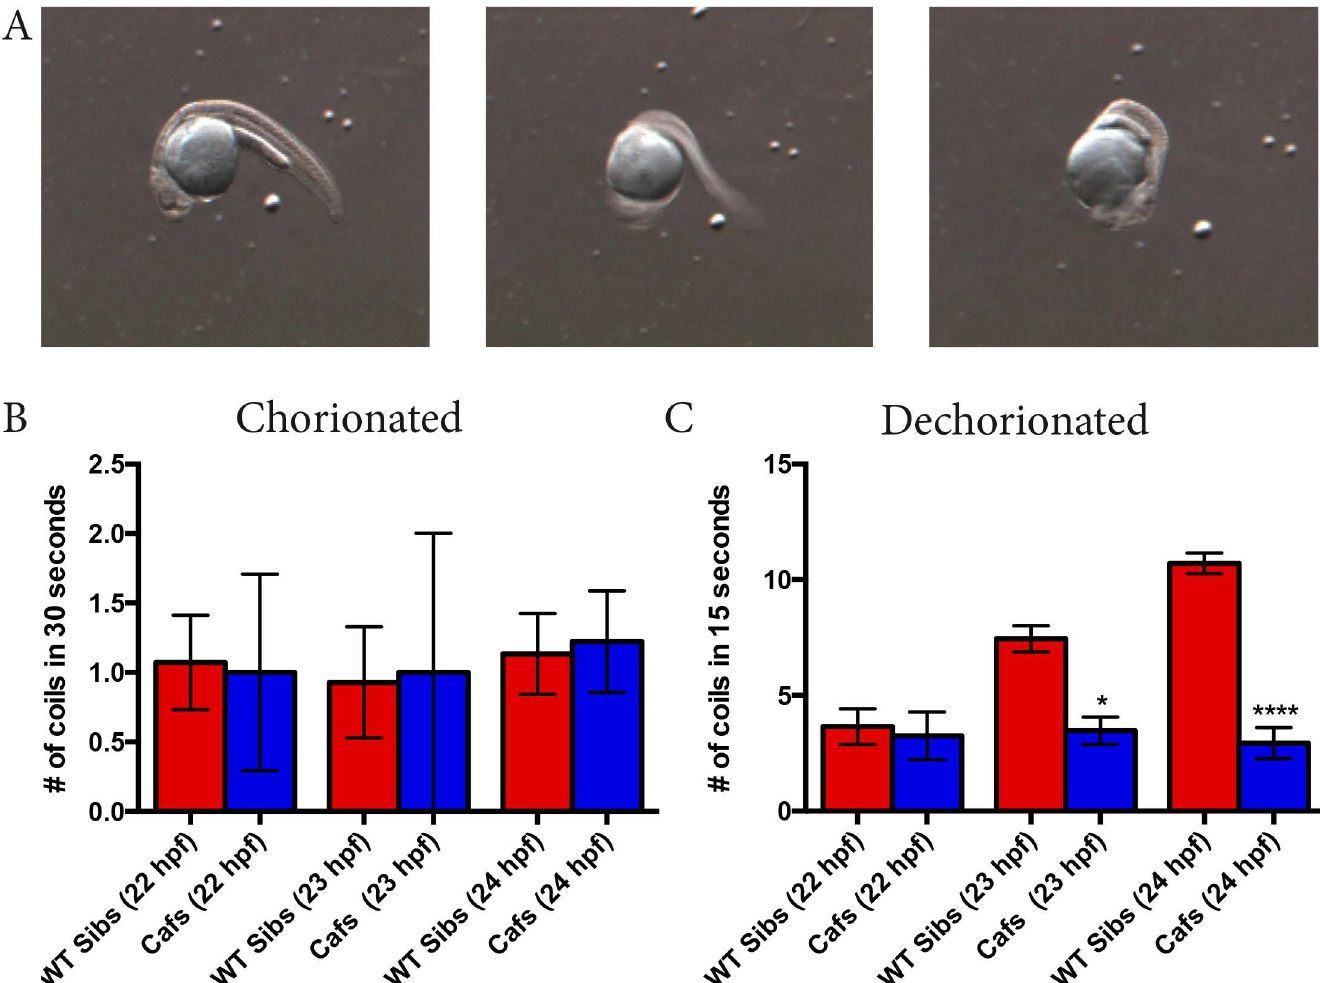
Fig 1. Caf mutants display a coiling phenotype as early as 23 hpf. A ) One full coil completedby a 24 hpf wild type ( lama2 +/+ and lama2 +/- ; WT) zebrafishembryo. B) Number of coils of WT siblingsand caf (lama2 -/- ) mutants over 30 seconds when left in their chorions.There is no